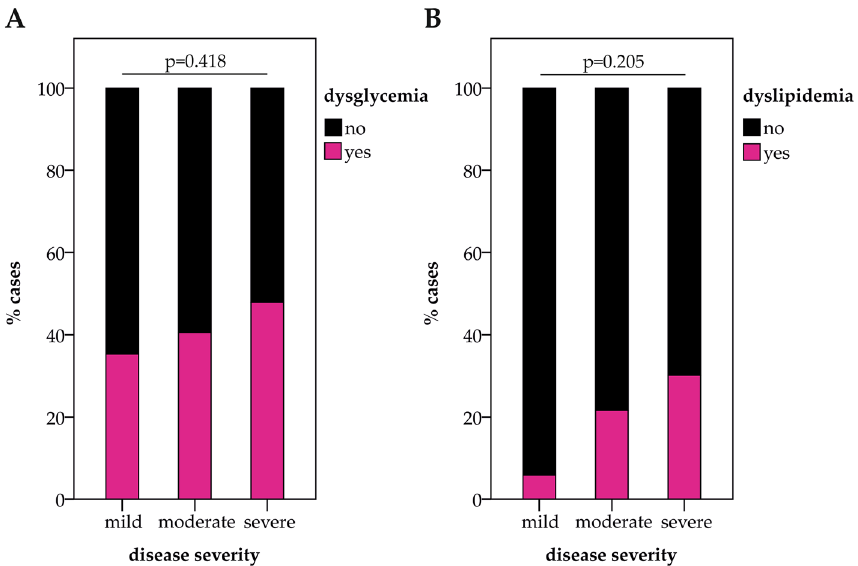
Figure 2. Dysglycemia and dyslipidemia at early post-acute follow-up after COVID-19. Patients were prospectively followed after acute COVID-19 and the presence of dysglycemia ( A ) and dyslipidemia ( B ) were assessed at 60 days post-COVID-19 follow-up. Bars depict the prevalence of dysglycemia and dyslipidemia in patients with mild, moderate and severe acute COVID-19. N total = 145, N dysglycemia = 62, N dyslipidemia = 32. P -values are reported according to Chi-Square